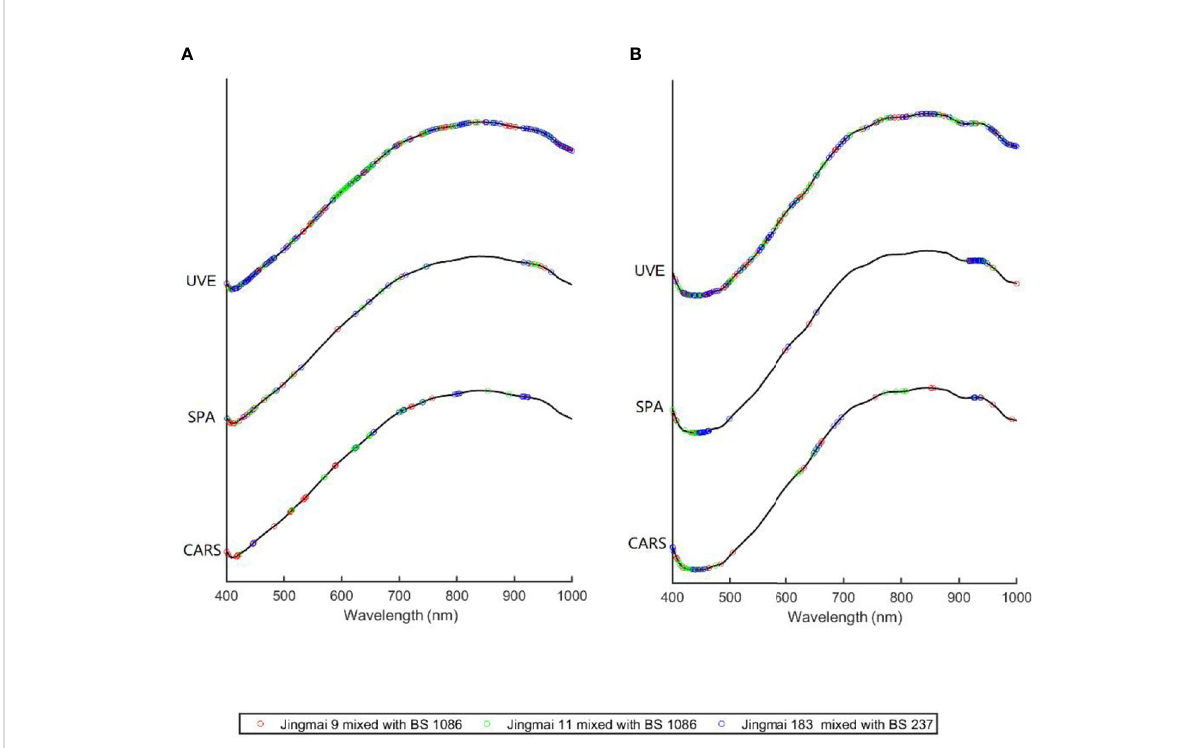
FIGURE 6 Detailed location of characteristic wavelengths screened using different methods: (A) re fl ectance spectrum and (B) transmittance